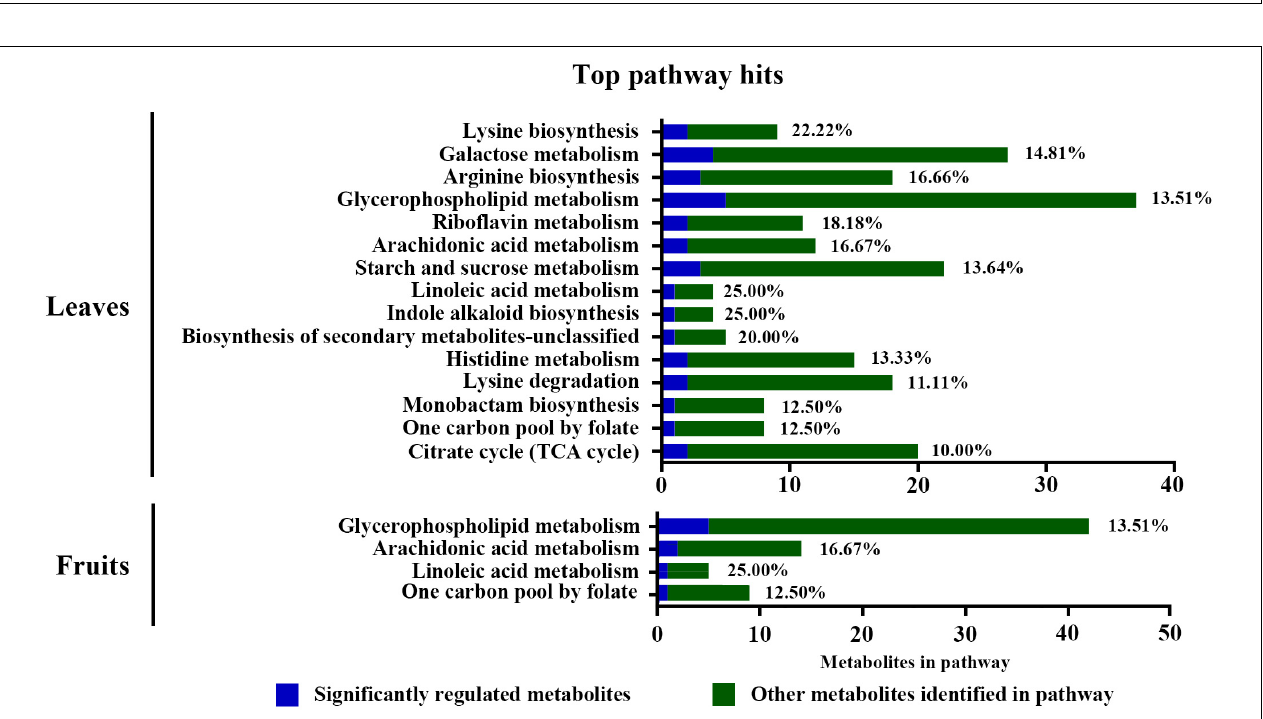
FIGURE 6 | Pathway analysis of the DEMs detected in leaves and fruits under non-fumigation and S fumigation, respectively. The x -axis represents the number of DEMs annotated in each pathway. The blue portions represent differentially detected metabolites, while the green portions represent the other annotated metabolites in the pathway. The percentages are the ratios of blue to green. Only pathways with at least 10% significant regulation were included.